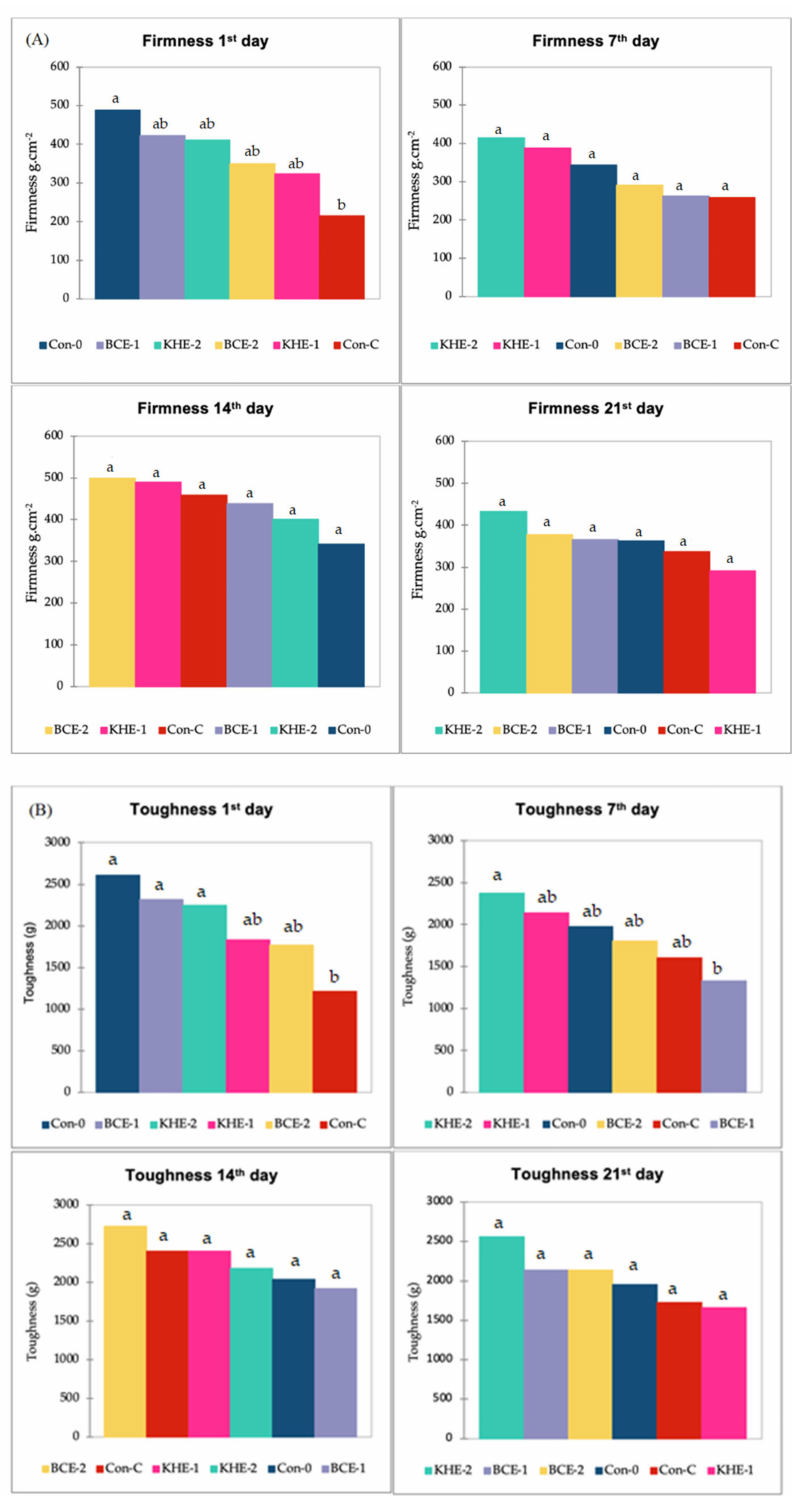
Figure 1. ( A ) Results of textural analysis (firmness) ANOVA comparation by Duncan test; ( B ) Results of textural analysis (toughness) ANOVA comparation by Duncan test. Note: a,ab,b represents statistically significant differences ( α = 0.05) between samples on every day of measurement in both firmness (g) and toughness (g · s); Con-0 = negative control, Con-C = control with 0.5 g vit. C, BCE-1 = 3 mL blackcurrant ext. addition, BCE-2 = 5 mL blackcurrant ext. addition, KHE-1 = 3 mL honeysuckle ext. addition, KHE-2 = 5 mL honeysuckle ext.